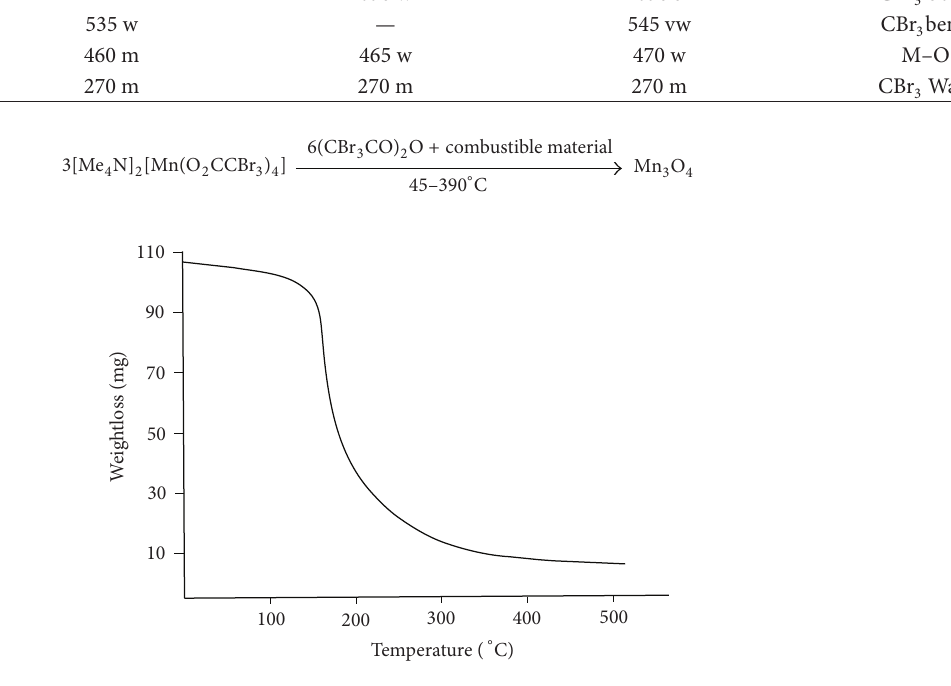
F 2: ermogravimetric curves of